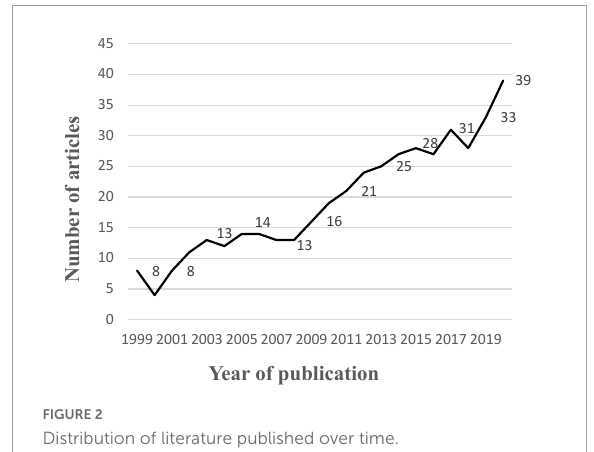
removed the duplicate documents from the search